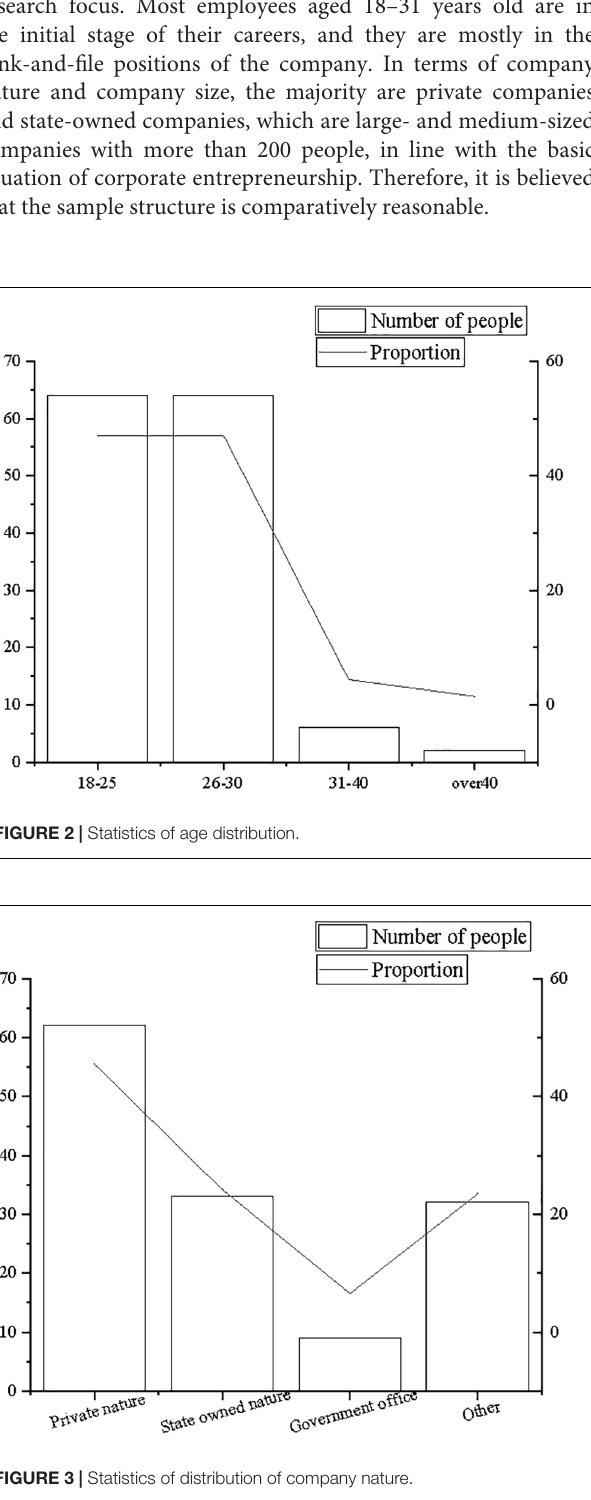
FIGURE 3 | Statistics of distribution of company